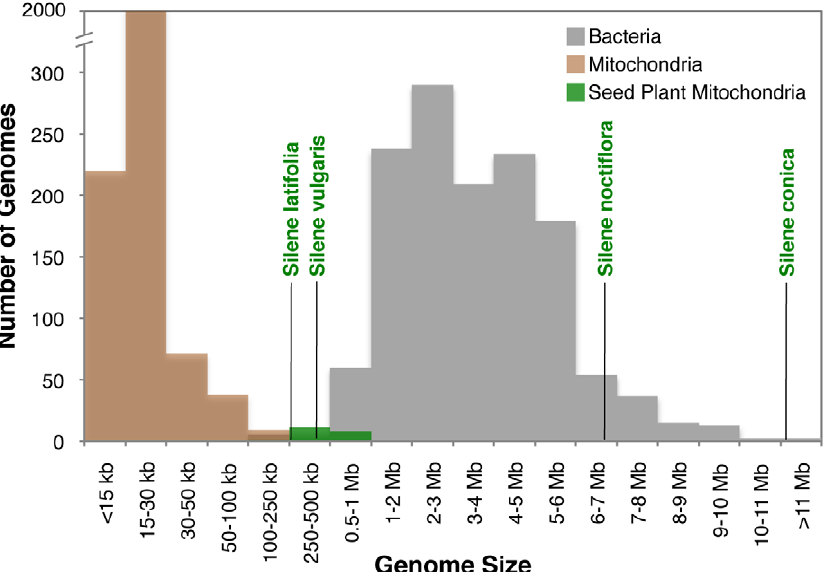
Figure 8. Silene mitochondrial genome sizes relative to all sequenced mitochondrial and eubacterial genomes from the National Center for Biotechnology Information (NCBI) Genome database.